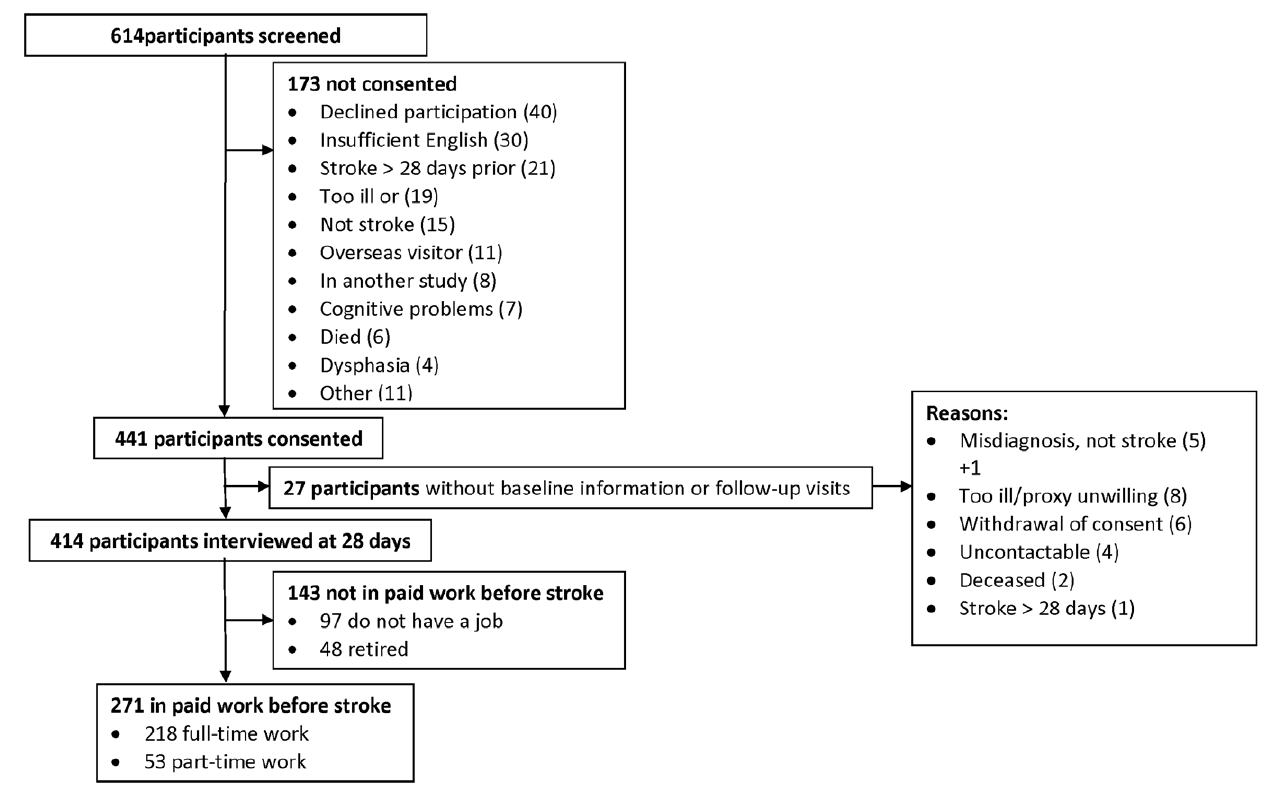
Figure 1. Flow of participants in POISE.